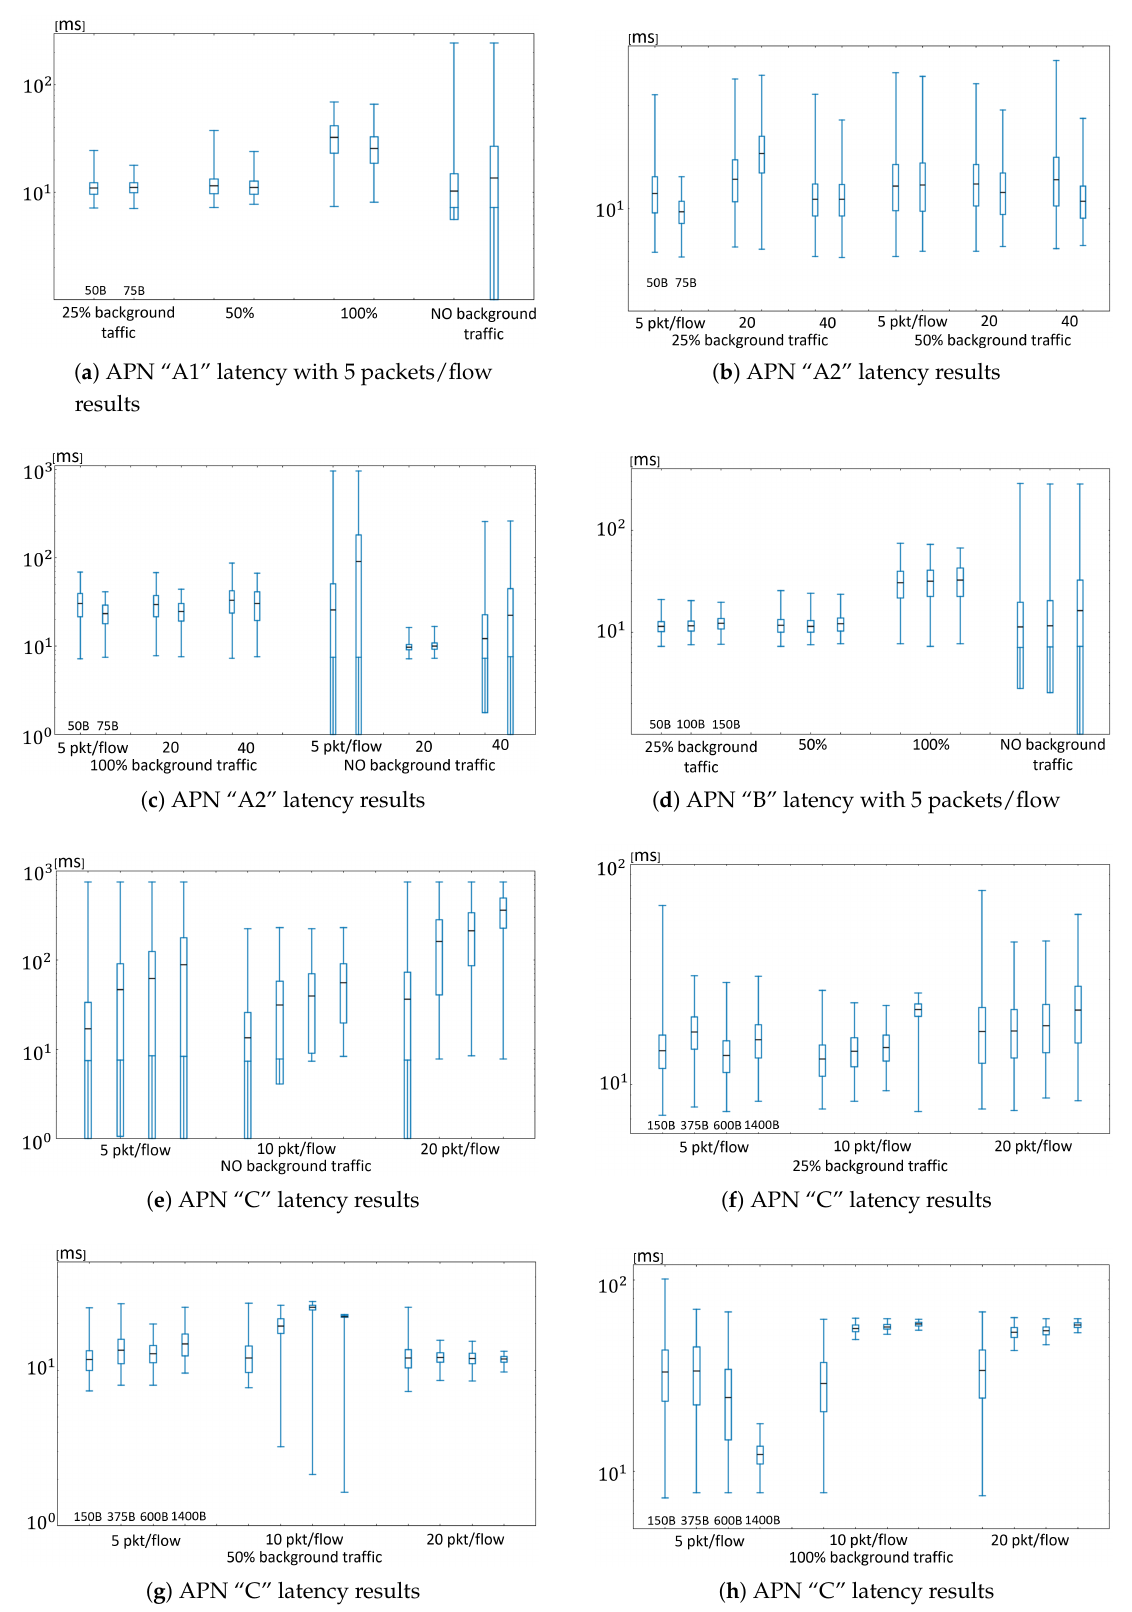
Figure 19. APNs latency results with different size, background traffic and